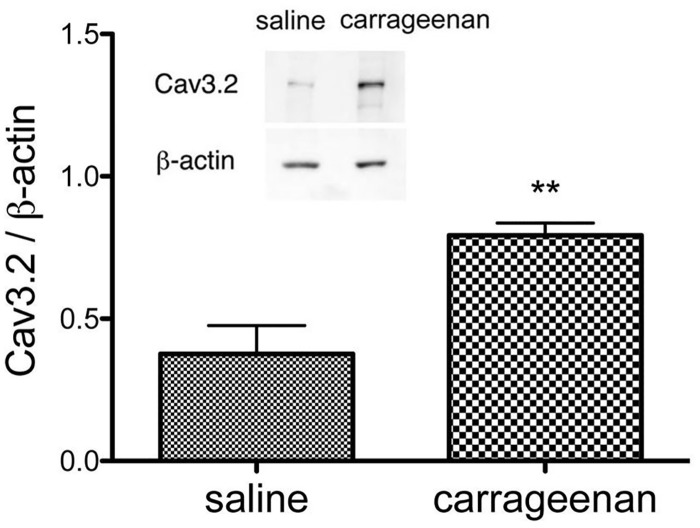
Cav3.2 protein expression is enhanced in ipsilateral L5 DRG tissues during the sub-acute phase (Day 2) following carrageenan injection.Cav3.2 protein expression was analyzed and normalized relative to the expression of the housekeeping protein ß-actin. The inset of a representative, original immunoblot shows the up-regulation of Cav3.2 protein (n = 6 mice for each group). *p < 0.05 compared with the saline control (unpaired Student's t-test).